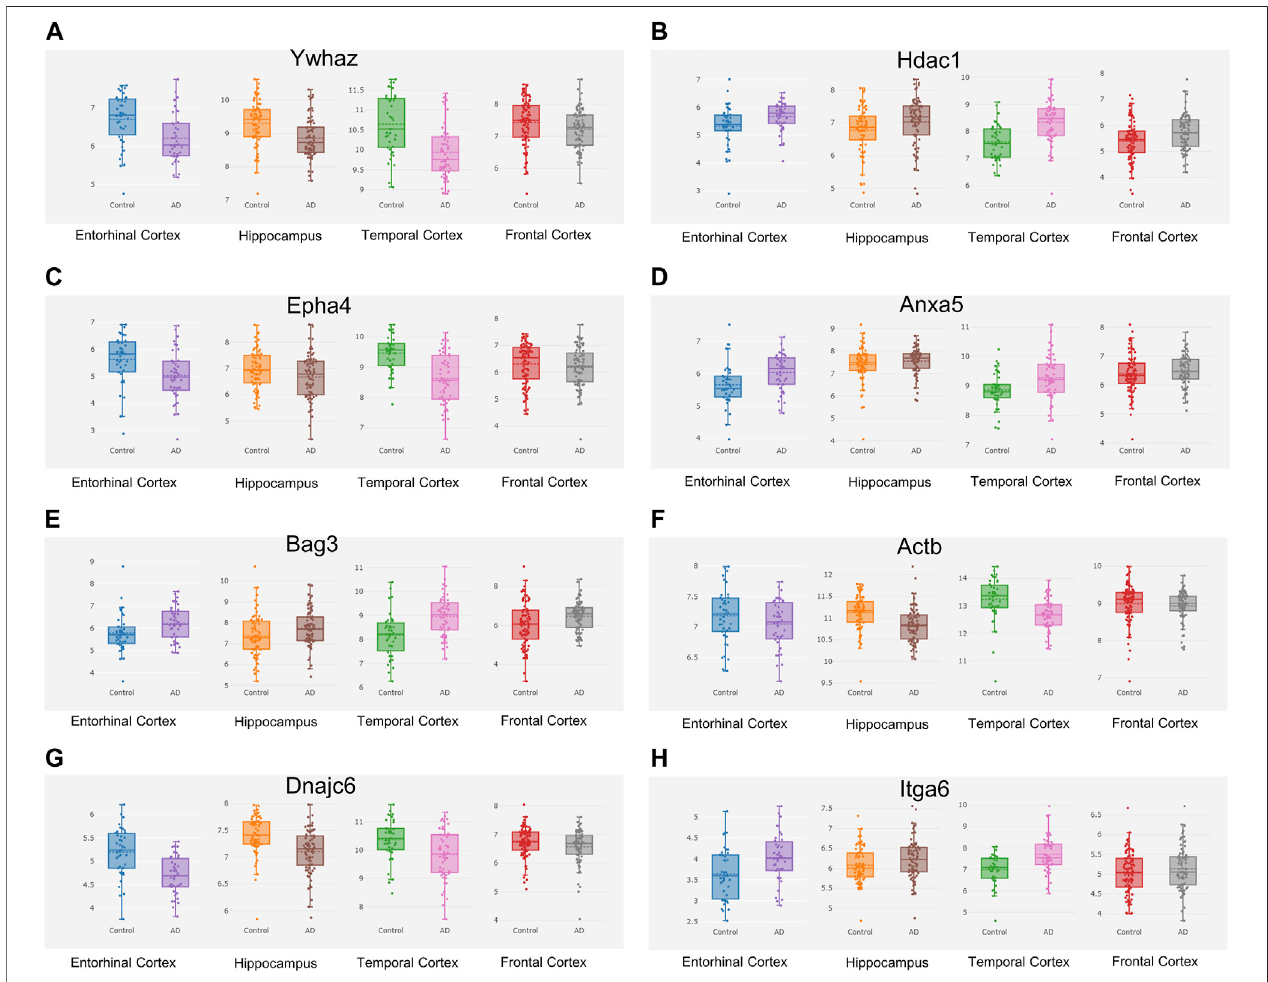
FIGURE 9 | Hub genes screened from the Alzdata database. The hub gene list was submitted to the Alzdata database for cross-checking, and its output showed the variation degree of each gene ’ s expression in four brain regions, including the entorhinal cortex, hippocampus, temporal cortex, and frontal cortex. The comparison resultsofthefourtypicalgenesinthedatabaseareshowninthepanel (A) Ywhaz (B) Hdac1 (C) Epha4 (D) Anxa5 (E) Bag3 (F) Actb (G) Dnajc6 (H) Itga6 .ECcontains39 controlsand39ADsamples,FCcontains128controlsand104ADsamples,HPcontains66controlsand74ADsamples,andTCcontains39controlsand52AD